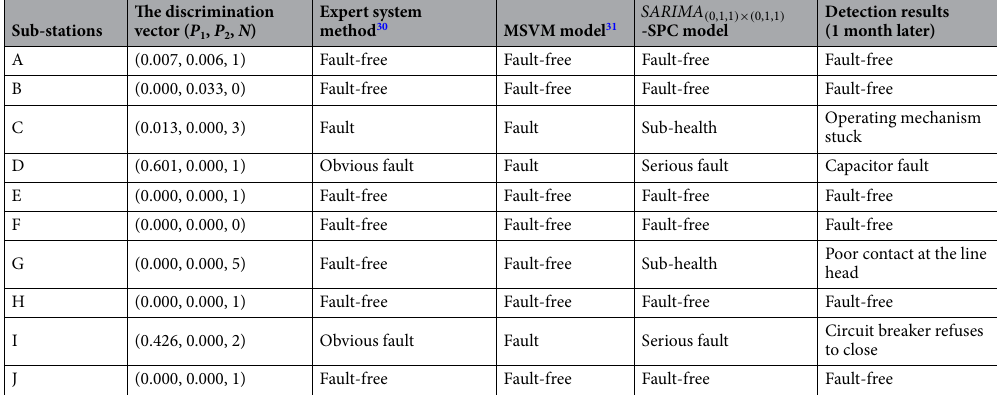
Table 3. The detection results of the SARIMA ( 0,1,1 ) × ( 0,1,1 ) -SPC model and other potential models in different substations. N is indicated as the number of 25 consecutive outlier points.